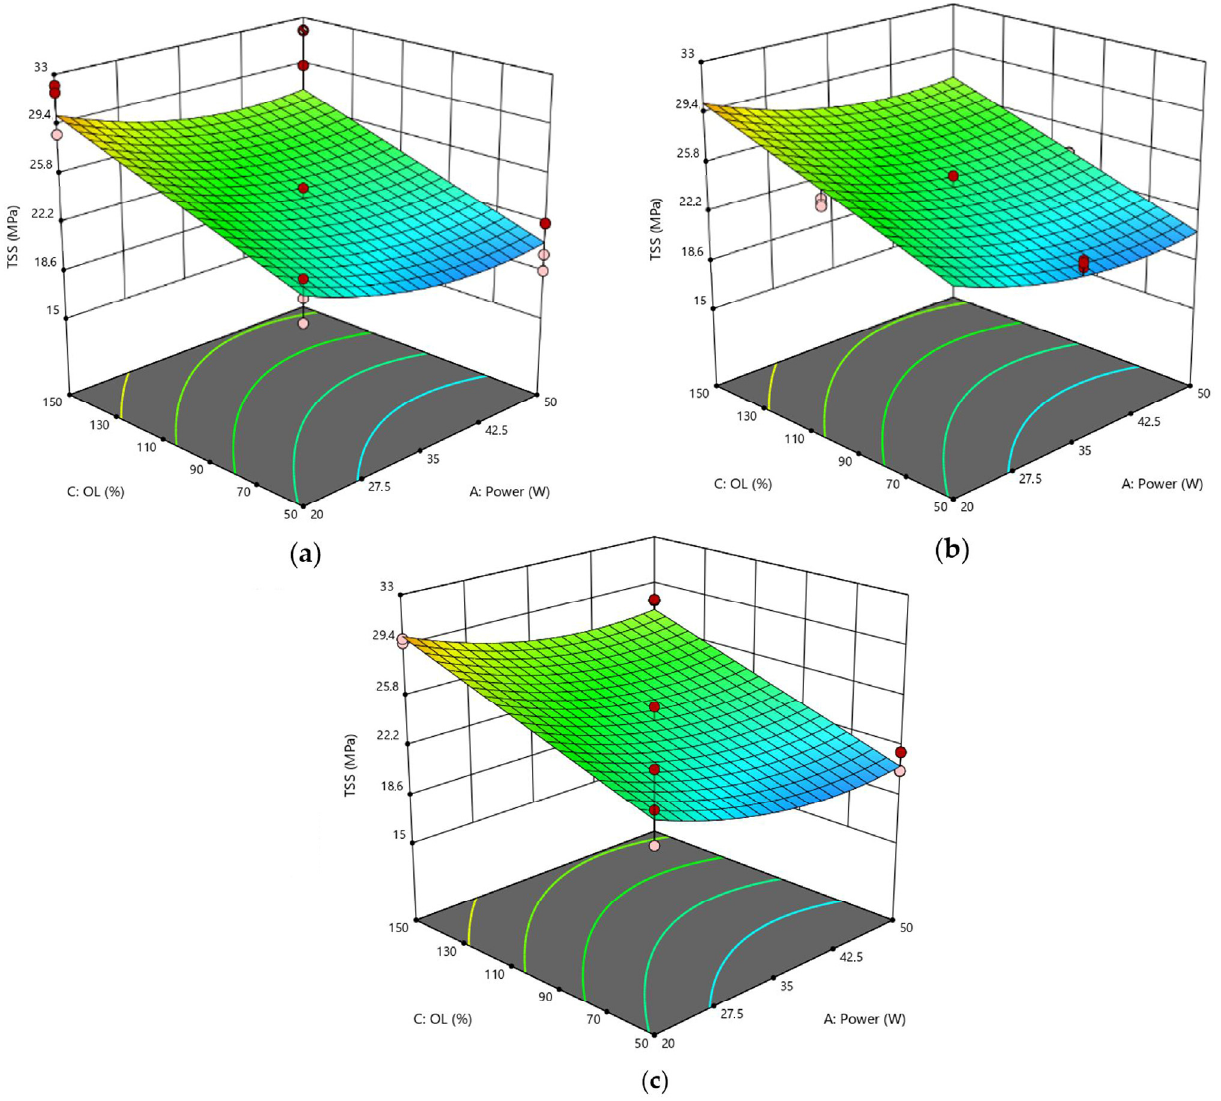
Figure 6. RSD 1: ( a ) h = 50%; ( b ) h = 100%; ( c ) h = 150%.